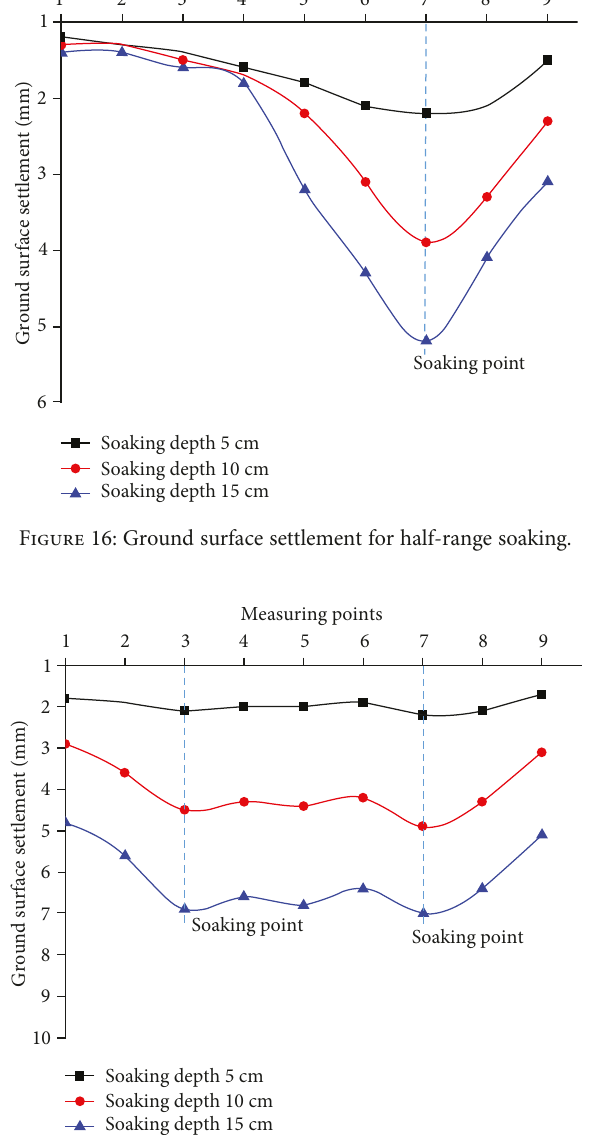
Figure 17: Ground surface settlement for full-range